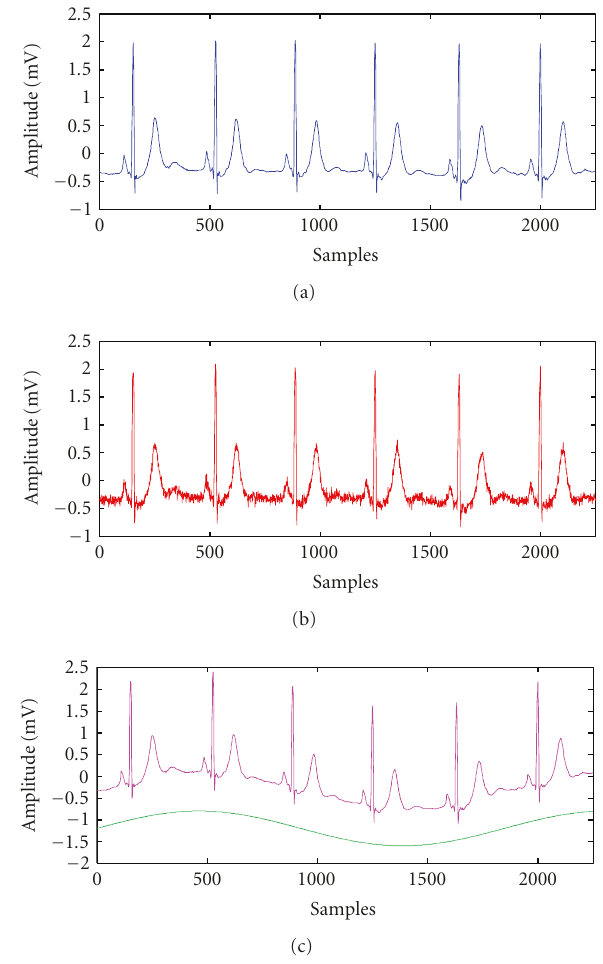
Figure 2: (a) Normal ECG, (b) noisy ECG, (c) baseline wandered ECG with its baseline